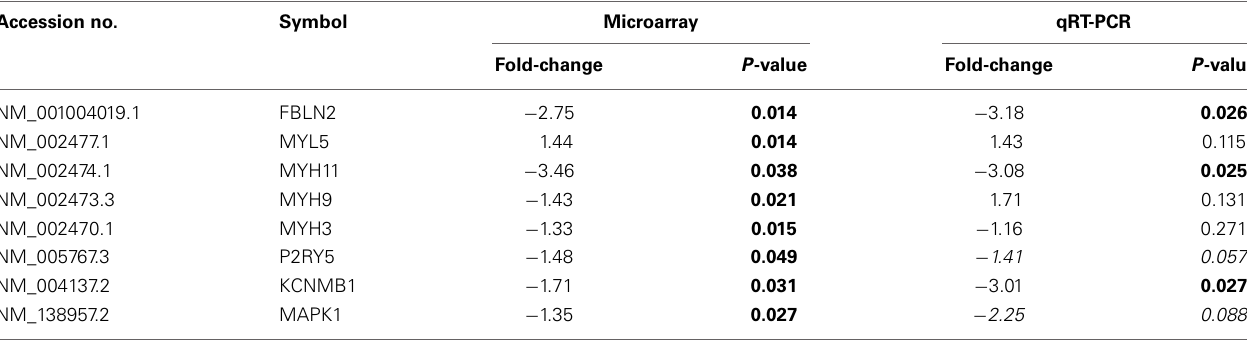
Table 3 | Results of the microarray and qRT-PCR experiments in MDDs. Accession